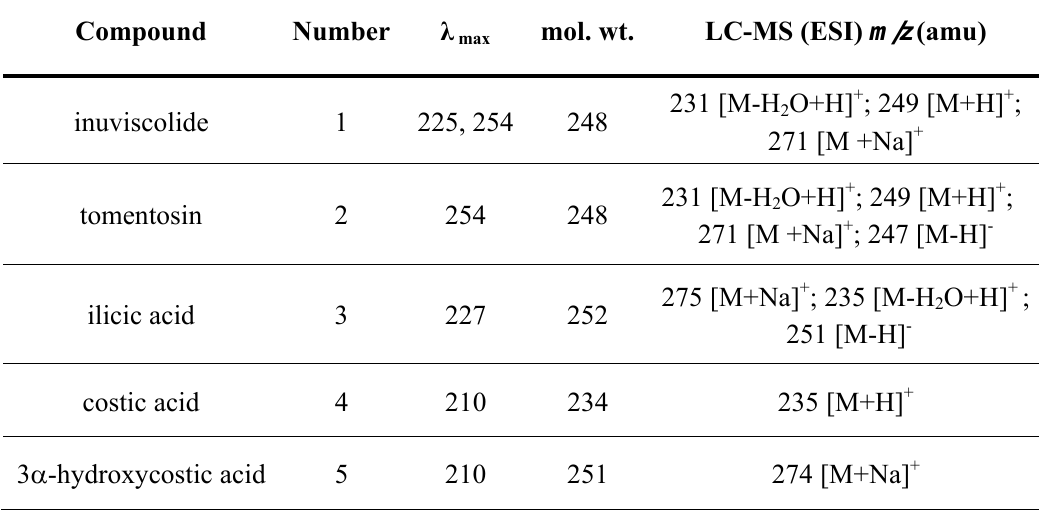
) detected in HPLC-DAD analysis and proposed max